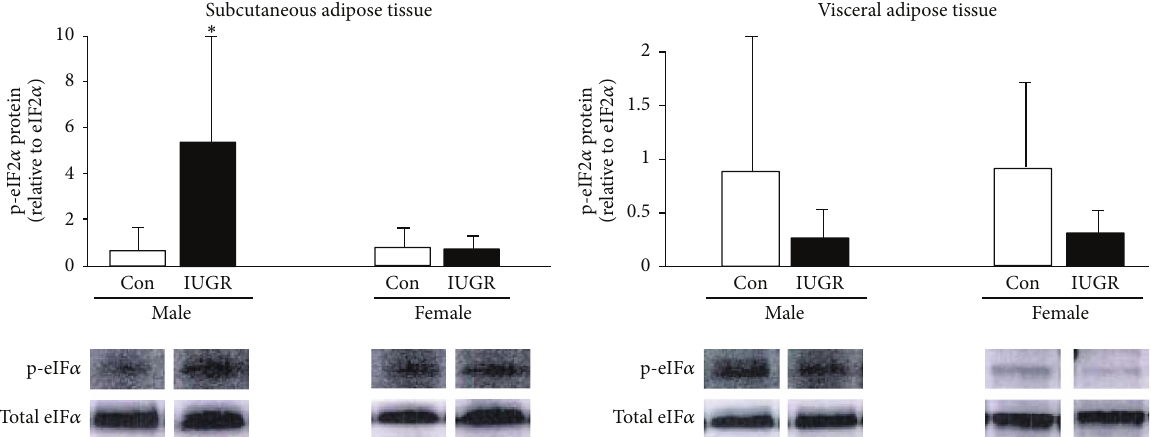
Figure 5: Phospho-eIF2 𝛼 levels. IUGR increases subcutaneous phospho-eIF2 𝛼 levels in male rats. Errors are SD. 𝑛 = 6 , ∗ 𝑃 ≤ 0.05